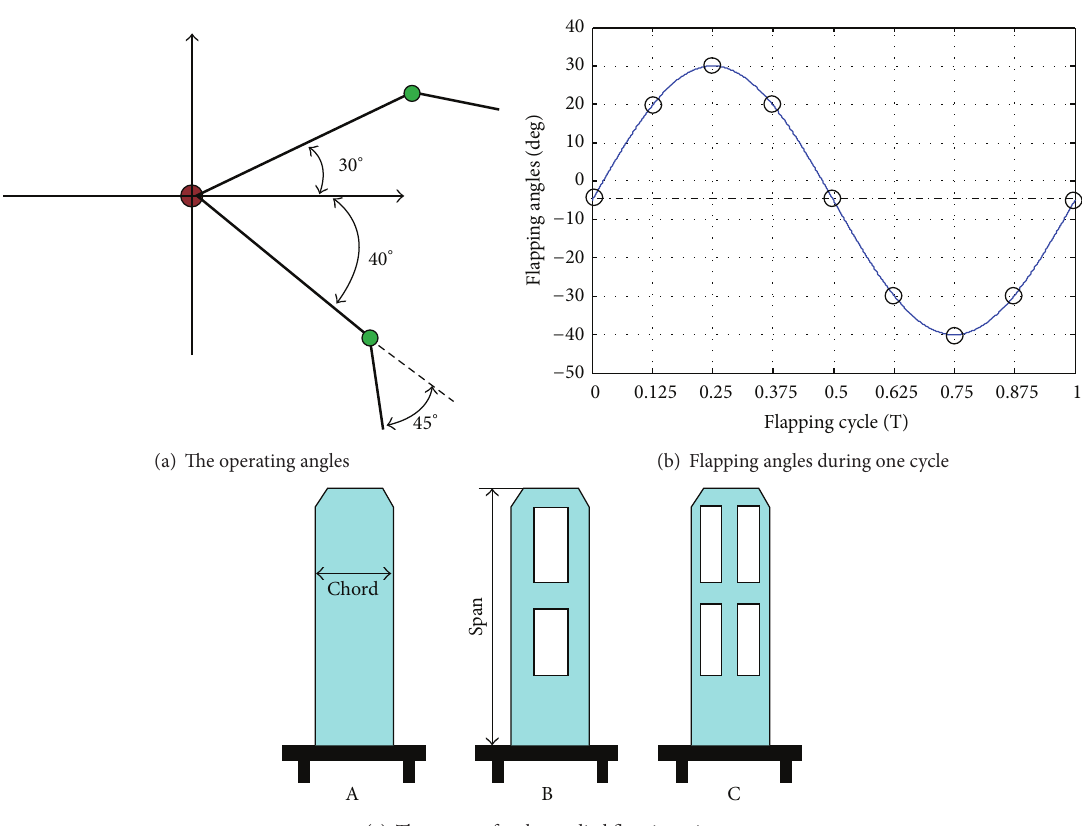
Figure 3: The operating process and wing shape type for the flapping mechanism.